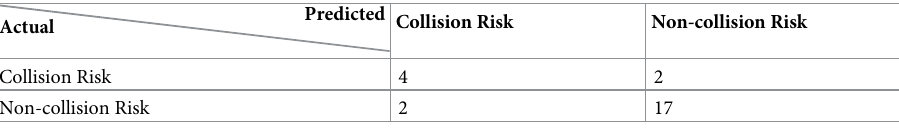
Table 2. Evaluation of the collision risk estimation